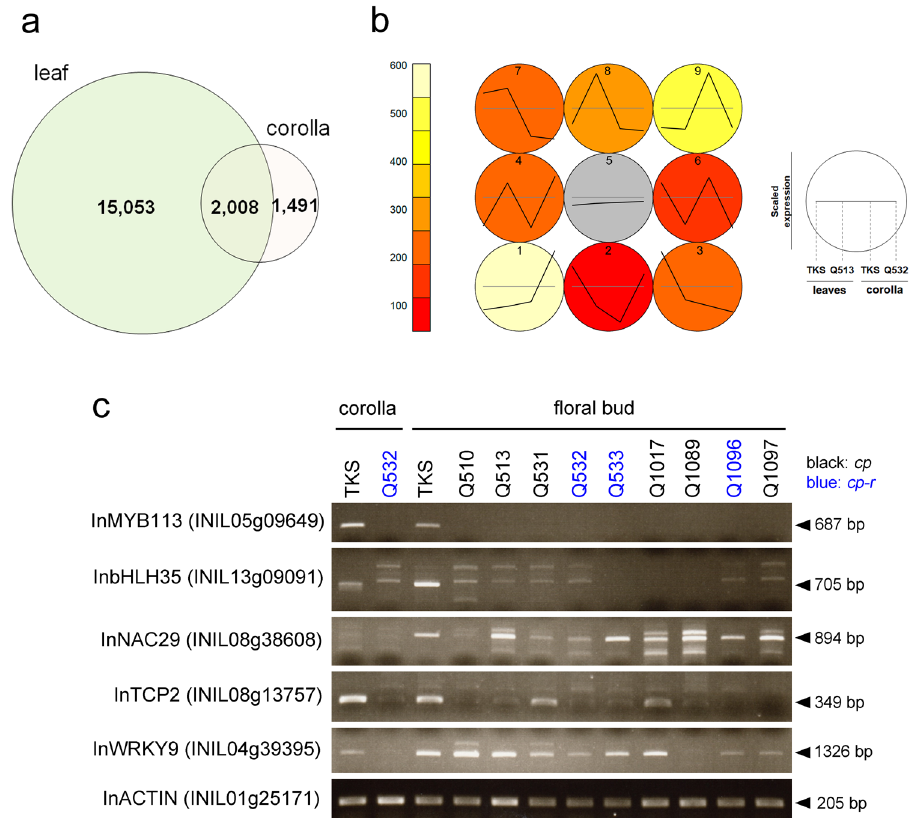
Fig. 4 Expression analysis in morning glory cup fl ower mutants. a Number of expressed genes in the leaves and corolla. b SOM clustering of expressed genes. The cluster number is shown in each circle. c RT-PCR results of transcription factor-encoding genes whose expression levels were downregulated in Q532, as revealed through RNA sequencing. The black and blue letters of the cup fl ower lines indicate cp and cp-r , respectively. The sample tissues